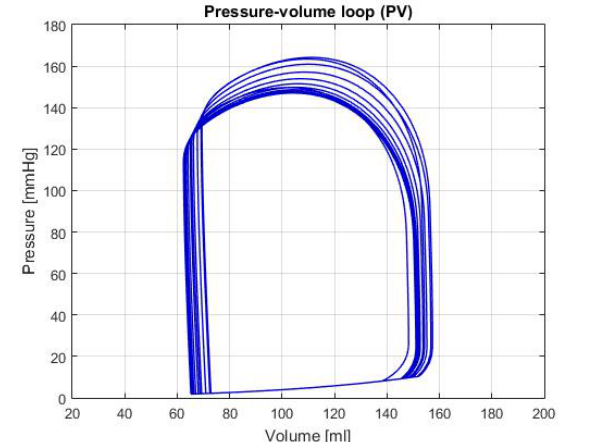
Figure 2. Graph of P-V loop curves in the left ventricle with a healthy